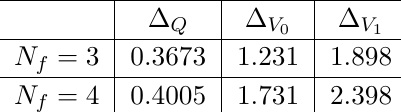
i (cid:16) 1+ w + w − 1 + 2 2 x 1 2 + t u